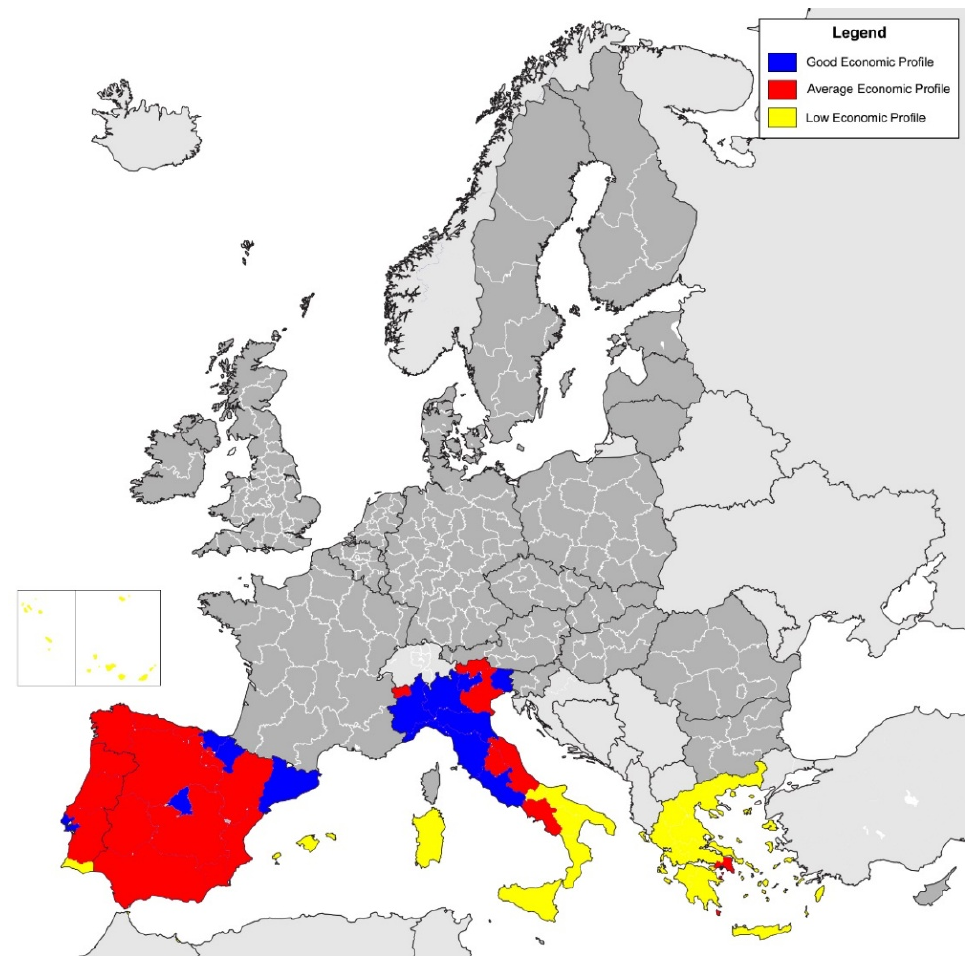
Figure 5: Clustering based on the regions’ economic